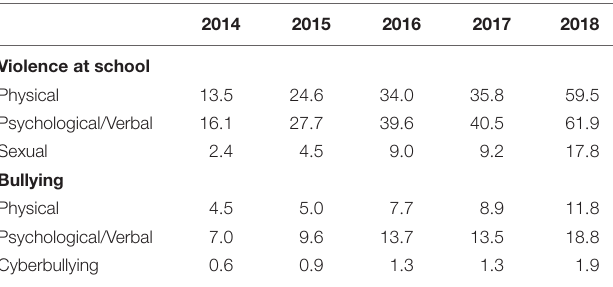
TABLE 1 | Rates of violence and bullying in the 2014–2018 period, according to reporting year.